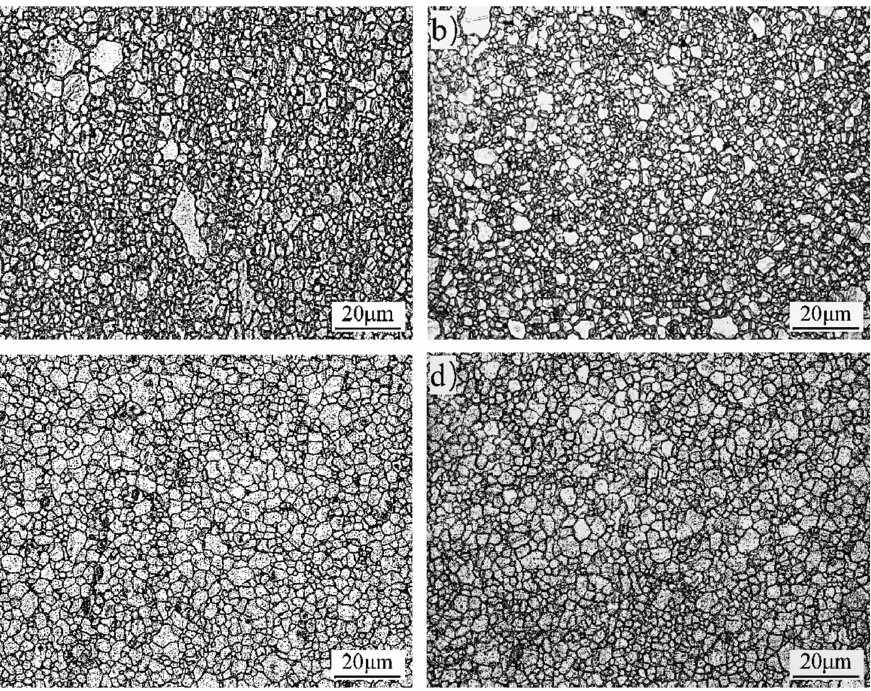
Figure 12: Microstructures in the extruded tubes under different extrusion conditions: (a) 300 ℃ , 0.5mm/s; (b) 300 ℃ , 1mm/s; (c) 400 ℃ , 0.5mm/s; (d) 400 ℃ , 1mm/s.